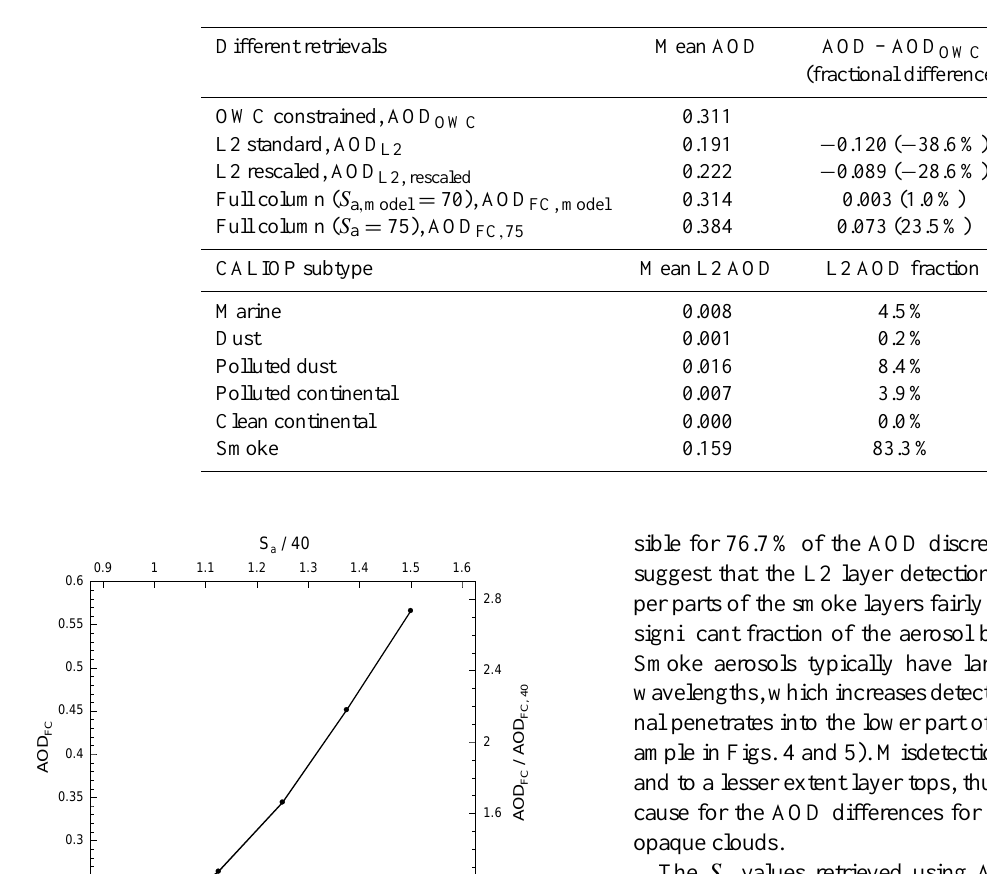
Table 3. AOD retrievals for smoke transport region over South Atlantic.